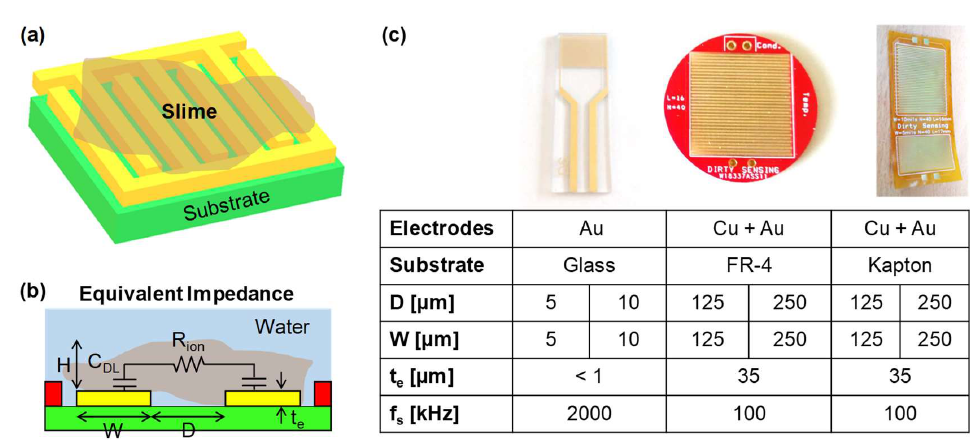
Figure 3. Slime thickness monitor based on planar interdigitated microelectrodes ( a ), of thickness t e , width W, and spacing D ( b ), fabricated in di ff erent technologies and geometries ( c ). Impedance is measured at a single frequency f s